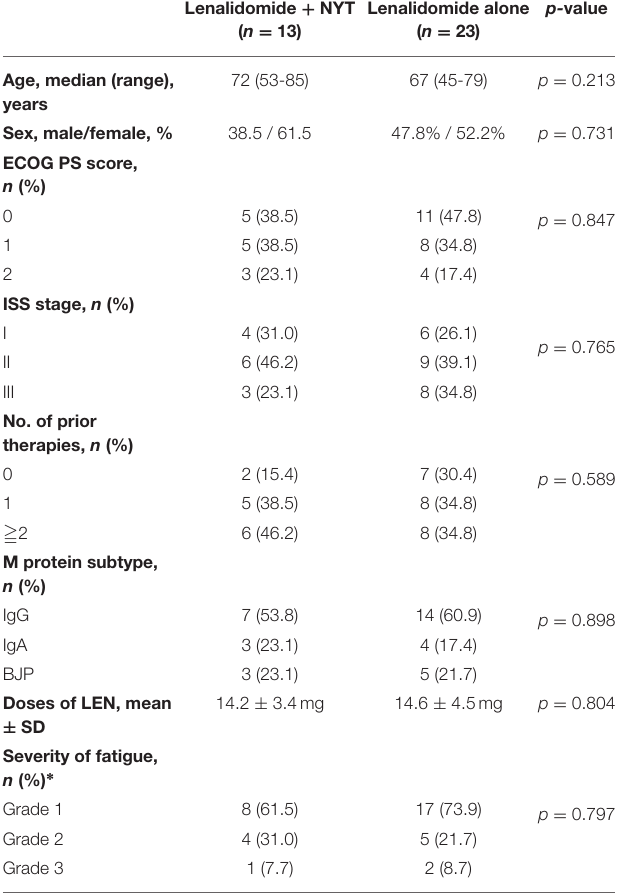
TABLE 1 | Patient base line